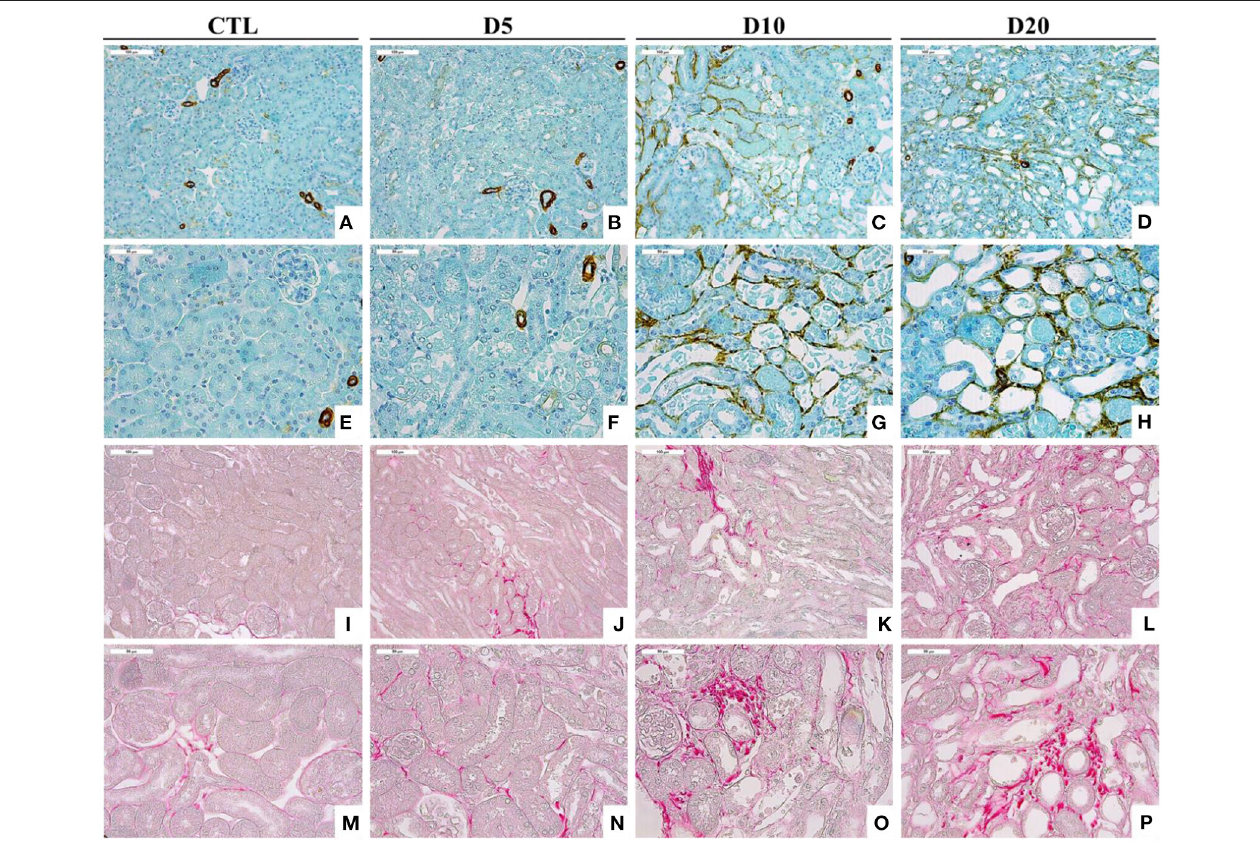
FIGURE 3 | Accumulation of α SMA-positive cells (A–H) and collagen I and III, highlighted by Sirius Red staining (I–P) , within the interstitium of the kidney of CTL mice and mice intoxicated with AA (aristolochic acid I, Sigma-Aldrich, St. Louis, MO, USA) during 4 consecutive days. Mice were sacrificed 5, 10, and 20 days after first day of AA treatment [Magnification x100 for (A–D) and (I–L) and x200 for (E–H) and (M–P)